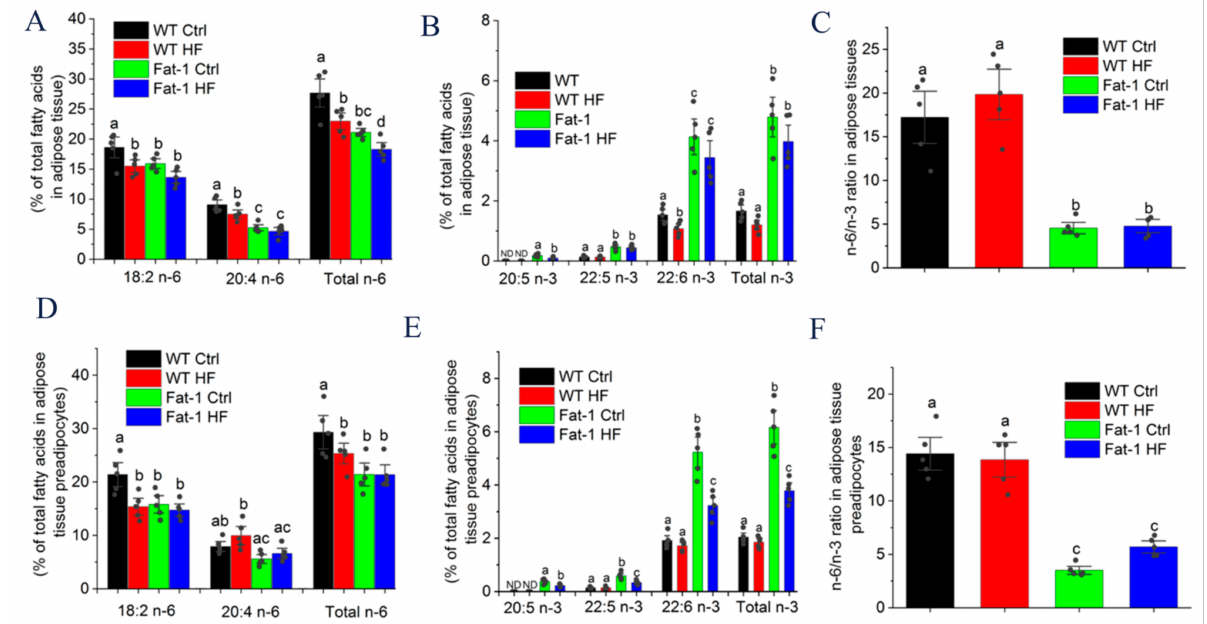
Figure 4. Major n-6 and n-3 PUFAs and the ratio of n-6/n-3 PUFAs in the adipose tissue or adipose tissue preadipocytes of WT and fat-1 mice fed a HF or Ctrl diet: ( A ) Major n-6 PUFAs in adipose